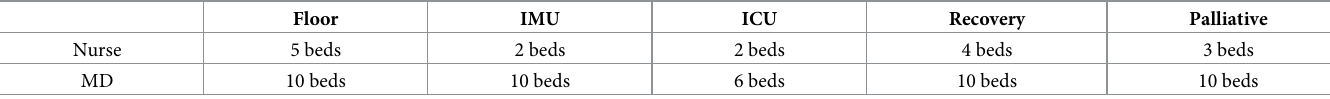
Table 4. Number of staff required at each care unit per beds in reference to the workflow of Fig